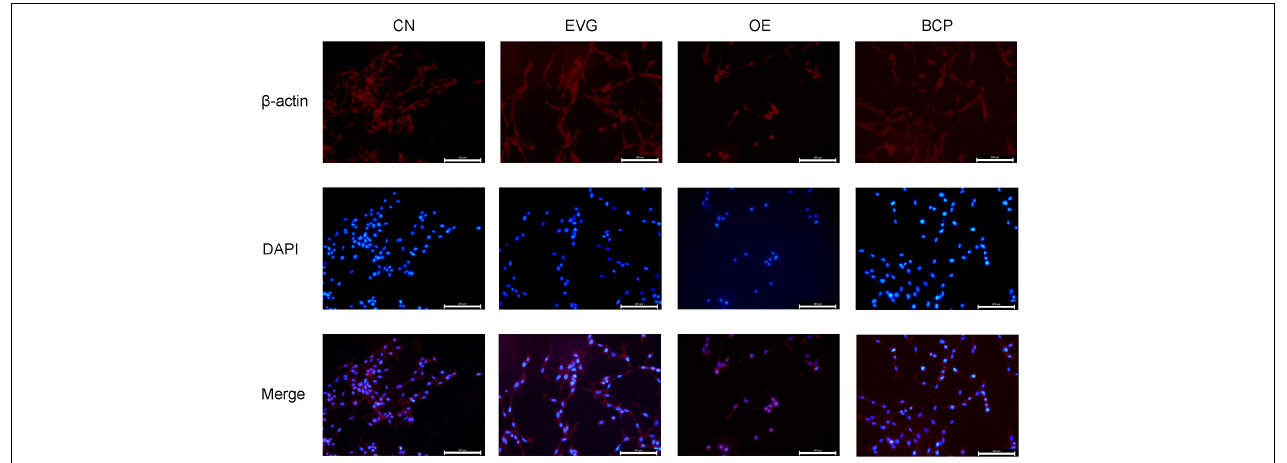
FIGURE 3 | Immunofluorescence detection of the effect of β -caryophyllene on the neurites of PC-12 cells with APP overexpression. CN denotes the control group without special treatment; EVG denotes the group in which the PC-12 cells were transfected with empty vectors plasmid for 72 h; and OE denotes the group in which the PC-12 cells were transfected with human APP plasmid for 72 h. In the BCP group, the PC-12 cells were transfected for 48 h to overexpress APP and 10 µ M BCP acted on the PC-12 cells for 24 h. Scale bar = 200 µ